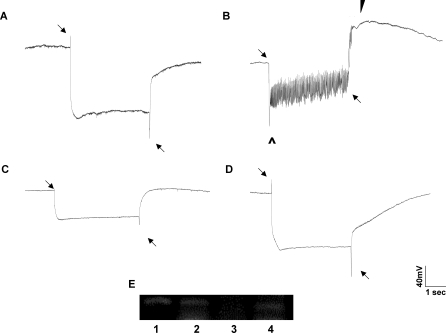
Rescue of ine2-Associated Oscillations with Expression of INE in Both Glial and Photoreceptor CellsERG recordings from (A) wild type, (B) ine2, (C) ine2 expressing the UAS-ineRB cDNA in photoreceptors, and (D) ine2 expressing the UAS-ineRB cDNA in glial cells. Arrows indicate on and off transients present in (A) wild-type but not (B) ine2 mutant recordings. A sharp depolarization response (unfilled arrowhead), a hyperpolarization (filled arrowhead) response and oscillations are present in (B) ine2 ERG recordings. Note that ine expression in either photoreceptor or glial cells results in a rescue of ine2-associated oscillations, on and off transients (arrows), and the hyperpolarization response. (E) Measurement of ine-RA and ine-RB mRNA in wild-type embryos or adult heads. 1 = ine-RA product from adult heads, 2 = ine-RA product from embryos, 3 = ine-RB product from adult heads, and 4 = ine-RB product from embryos. The ine-RA PCR product is 336 bp, while the ine-RB product is 338 bp. Note that there is very little ine-RB mRNA found in adult heads.